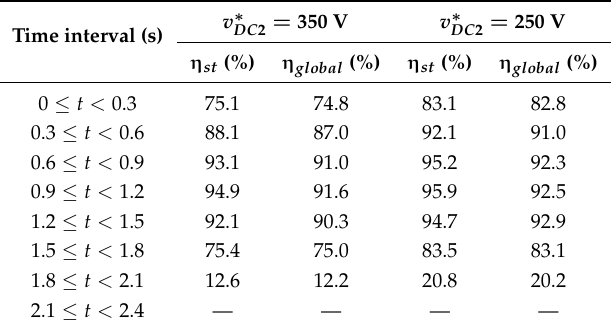
Table 11. Efficiencies calculated in the G2V mode when k = 0.7 k n .